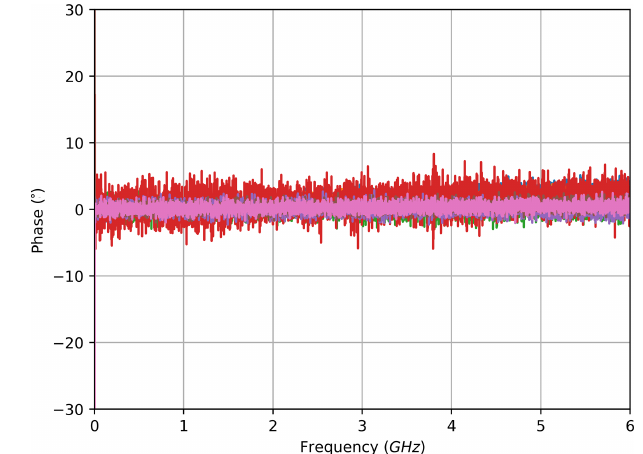
Figure 14. Electrical phase of S21 measurements of a cFBG in reflection configuration.